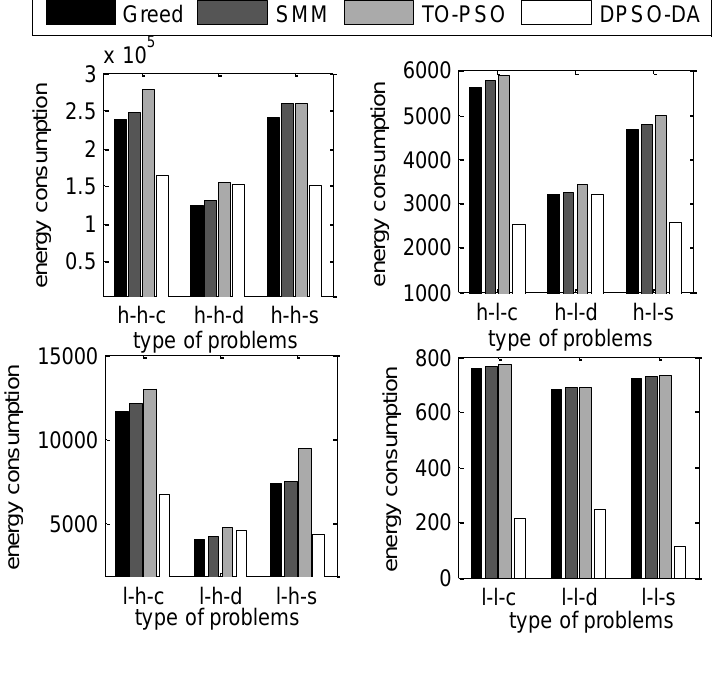
Figure 7. The total energy consumption under different task allocation